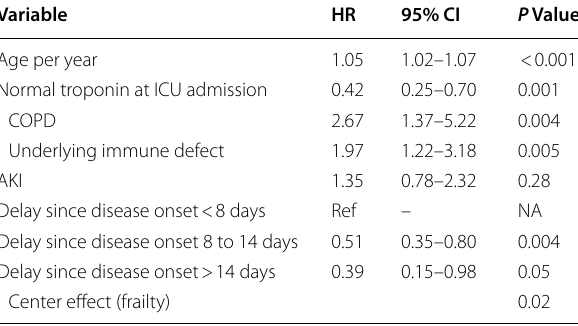
Table 3 Factors associated with day 28